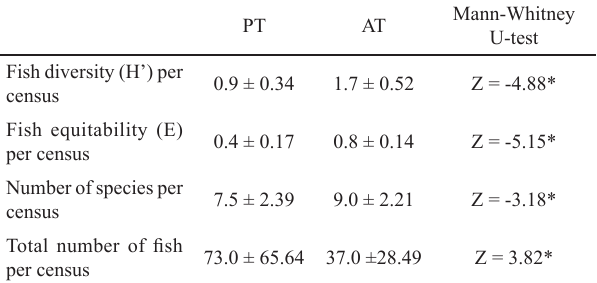
Table 3. Summary of reef fish community structure variables (median ± SD) plus the Mann-Whitney U-test results of comparisons between the two periods, at presence of tourists (PT) and at absence of tourists (AT). Statistical significance: p < 0.001(*).